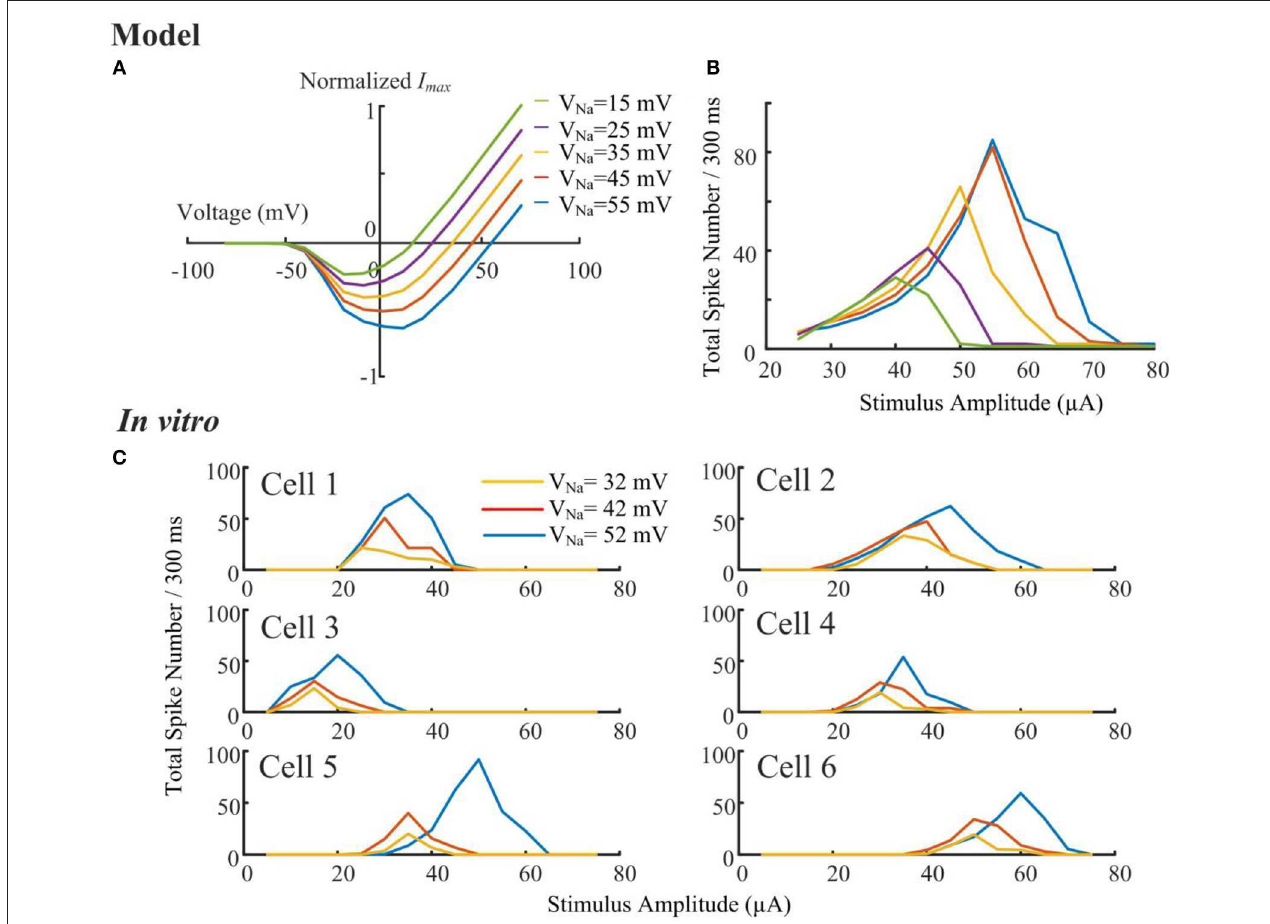
FIGURE 6 | Sodium reversal potentials alter the strength-dependent response. (A) Normalized I-V relationship of the model RGC sodium current for various reversal potentials ( V Na ). Shifting V Na to a more positive value delays the reversal of the sodium current. (B) The modeled stimulus-response profile for various V Na values. Shifting V Na to a more positive value increases RGC excitability during HFS, postponing the suppressive effect, and vice versa . (C) In vitro results of HFS response curves with different V Na values ( N = 6). The experimentally recorded RGC responses in mouse RGCs generally agree with the simulation results shown in panel B, with respect to the changes in amplitude and width of the response curve. (D1,D2) Comparison of model-prediction (red) and experimental data (black) in response to different Na + solutions. Model predictions and in vitro data exhibited similar normalized trends of the total elicited spike number during all pulse trains (D1), and the normalized onset of the falling phase in the spike-stimulus curve in which the total spike numbers saturated or declined (D2). Examples of total elicited spike number and onset was provided in subplots in D1 and D2, respectively. The error bars indicate standard deviation.